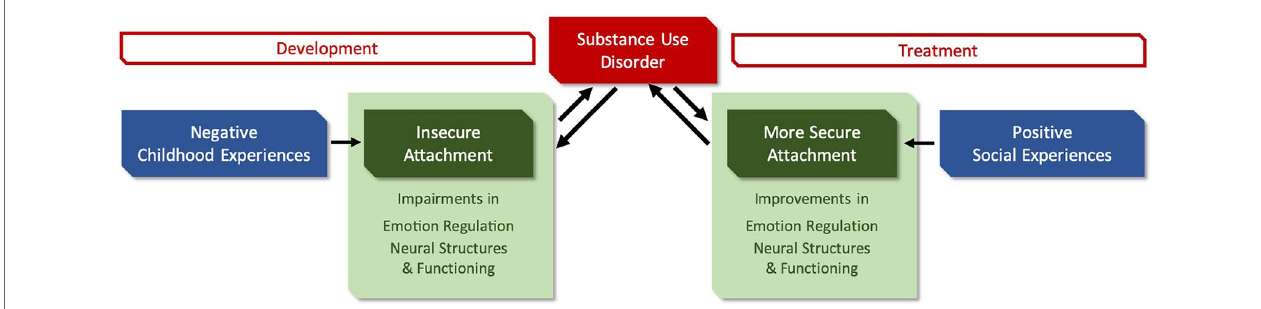
FIGURE 1 | Brief overview of the influence of attachment on SUD. The figure details the role of attachment patterns that form through social experiences, as well as related parameters on the development and treatment of substance use disorders